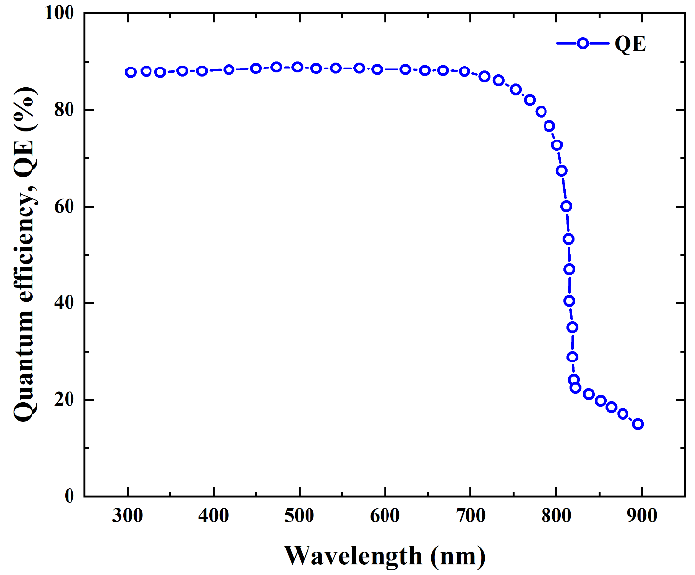
Figure 9. Quantum efficiency versus wavelength.